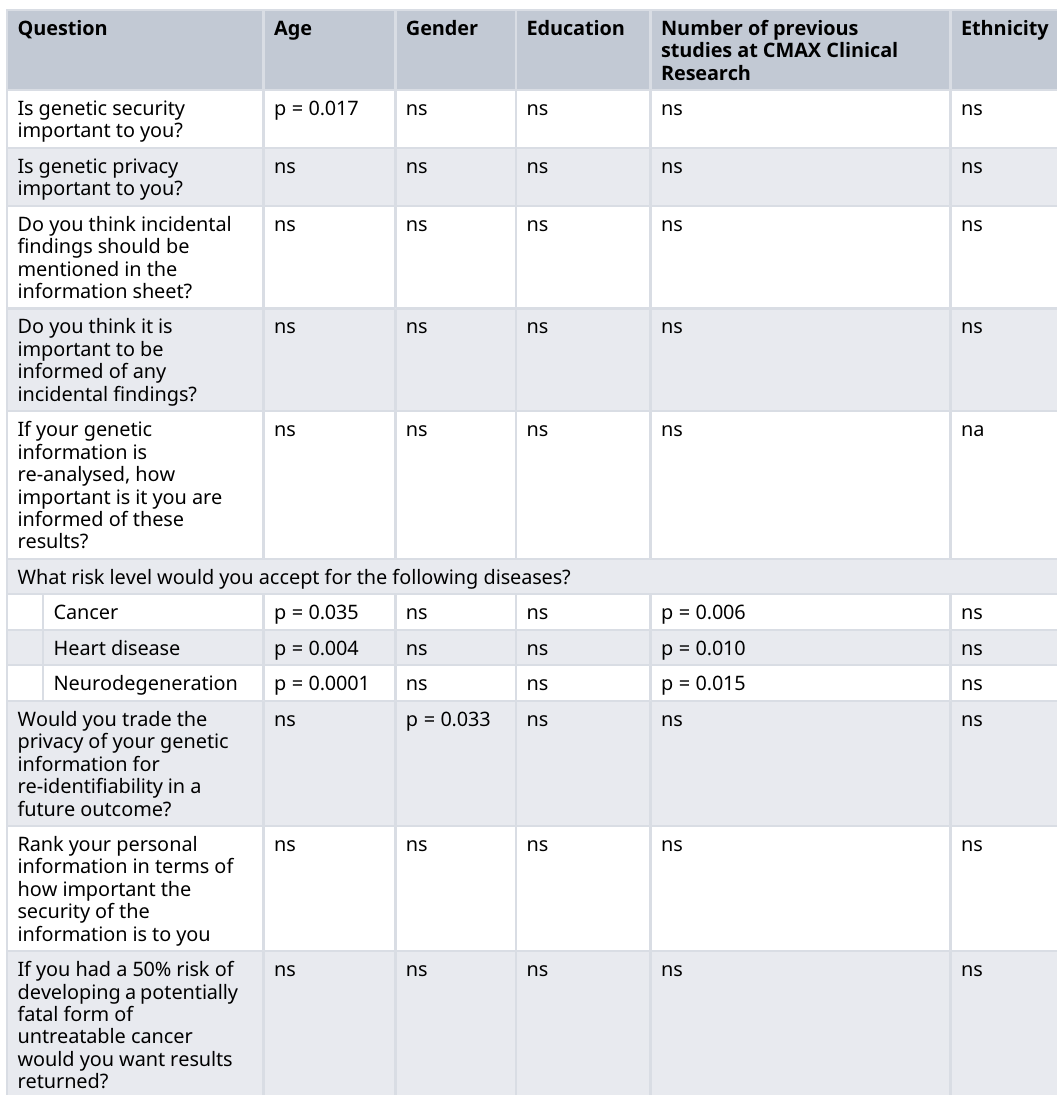
Table 3. Statistical